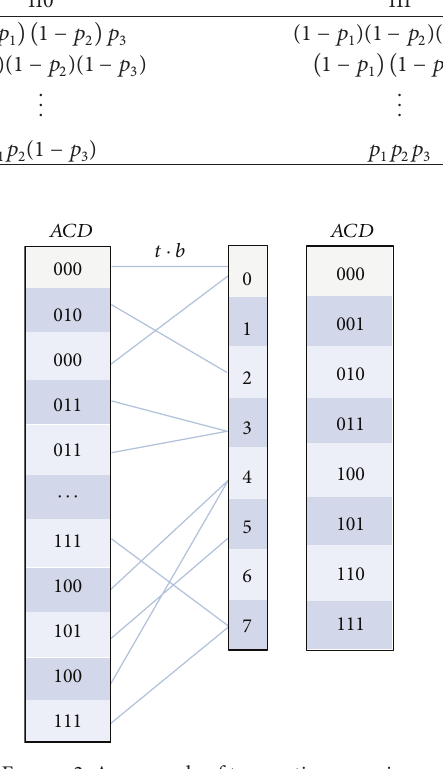
Figure 2: An example of transaction